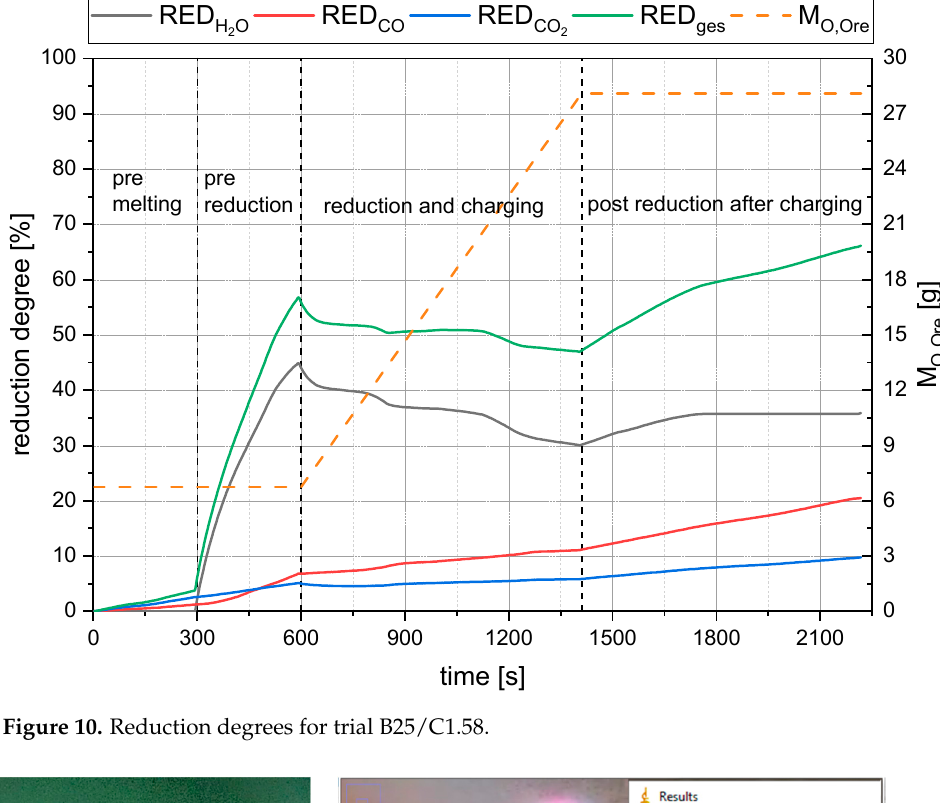
Figure 10. Reduction degrees for trial B25/C1.58.